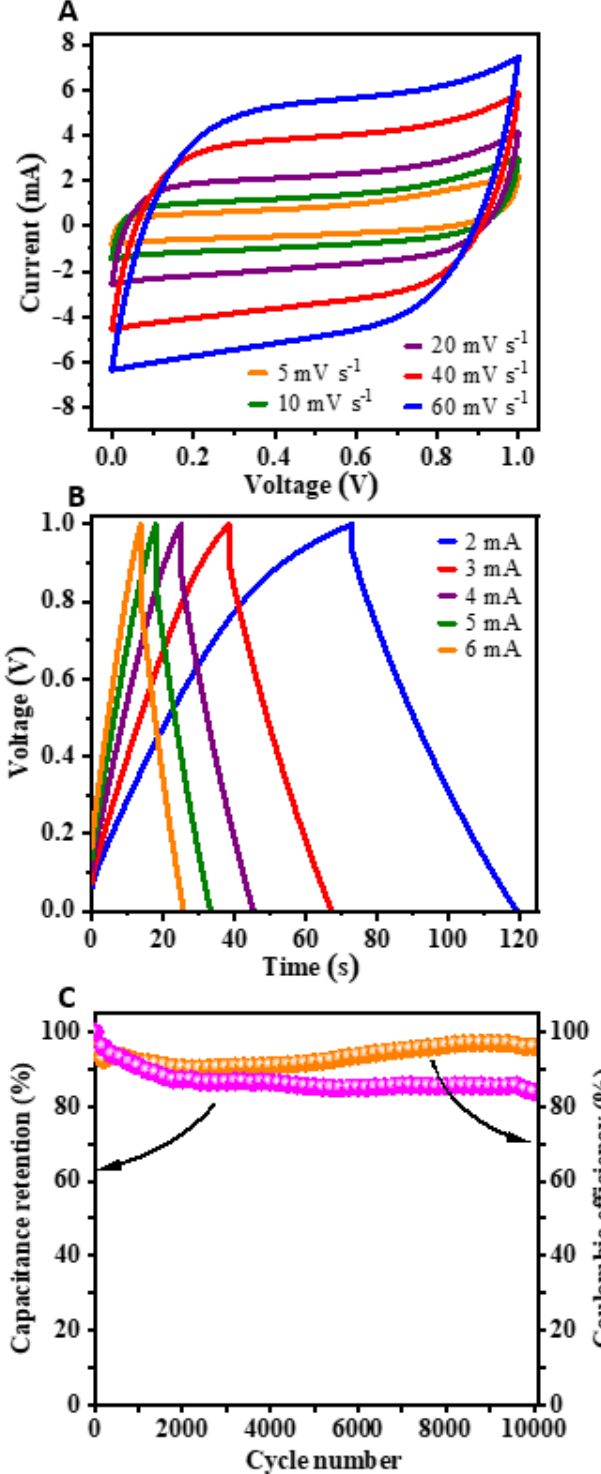
Figure 8. ( A ) CV at varying scan rates (5, 10, 20, 40, and 60 mV s − 1 ) and ( B ) GCD profiles at varying current rates (2, 3, 4, 5, 6 mA) of the symmetric capacitor device (KAC urea /KAC urea ) in an aqueous 2 M NaOH electrolyte with a 1 V window. ( C ) Capacitance retention and coulombic efficiency over 10,000 cycles.